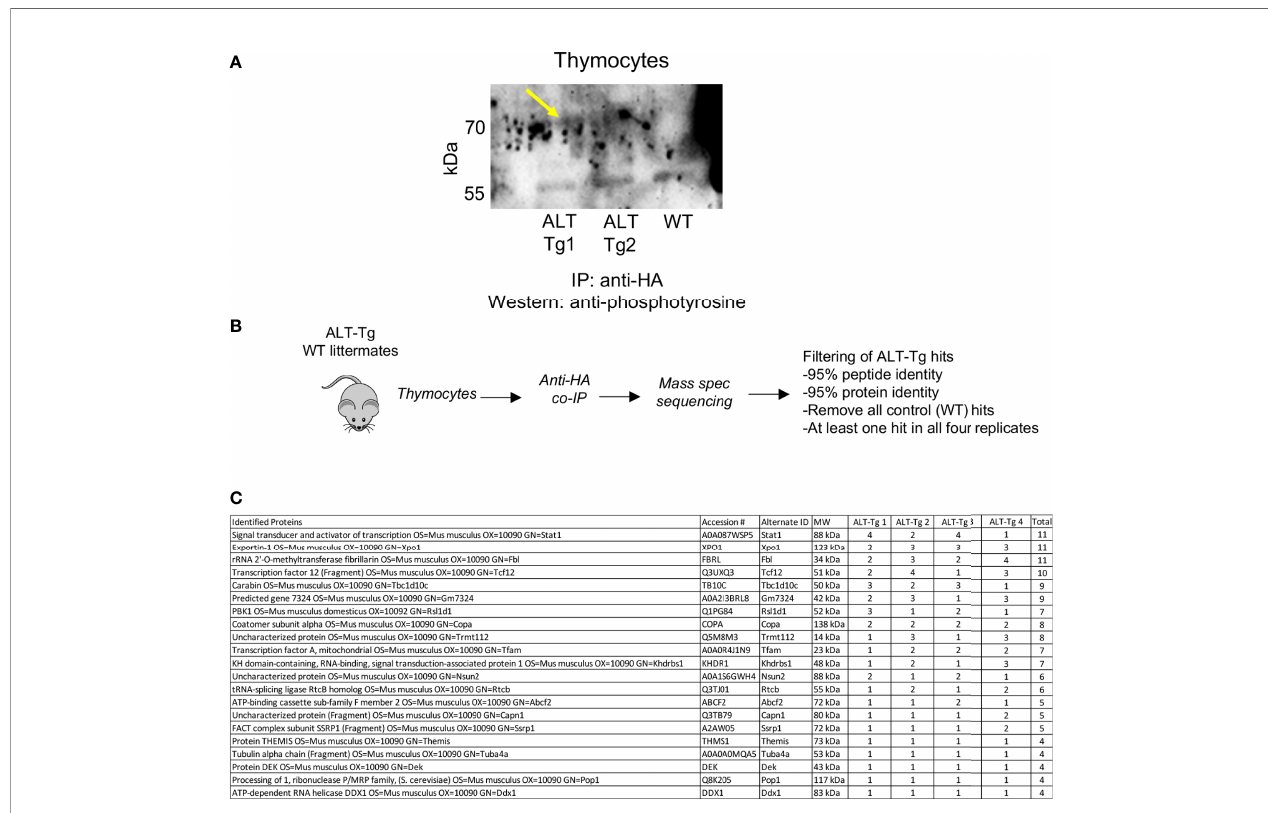
FIGURE 10 | Identi fi cation of potential proteins in HEB-containing complexes in ALT-Tg thymocytes. (A) Western blot of thymocyte lysates from two ALT-tg mice and one WT littermate immunoprecipitated with anti-HA and probed with anti-phosphotyrosine. The yellow arrow indicates the bands of ~70 kD, corresponding to the size of HEBAlt, that are present in both ALT-Tg samples but not in the WT sample. (B) Diagram of experimental design and protocol. (C) Identities, molecular weights, and numbers of spectra detected across four replicates for all proteins identi fi ed as potential HEBAlt complex partners by the criteria shown in (B)